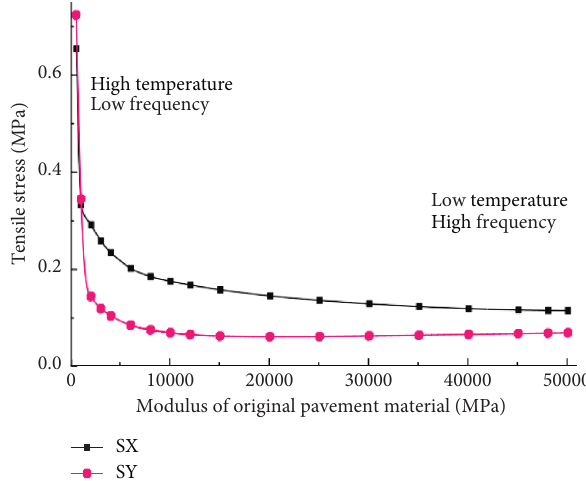
Figure 24: The effect of original pavement material modulus on tensile stress of patch block.